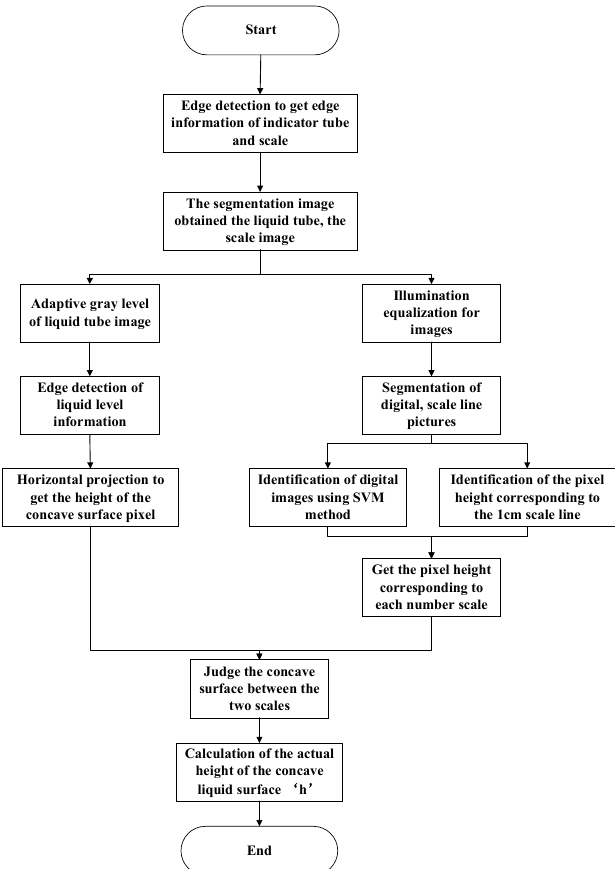
Figure 5. A general block diagram for the liquid level recognition algorithm.